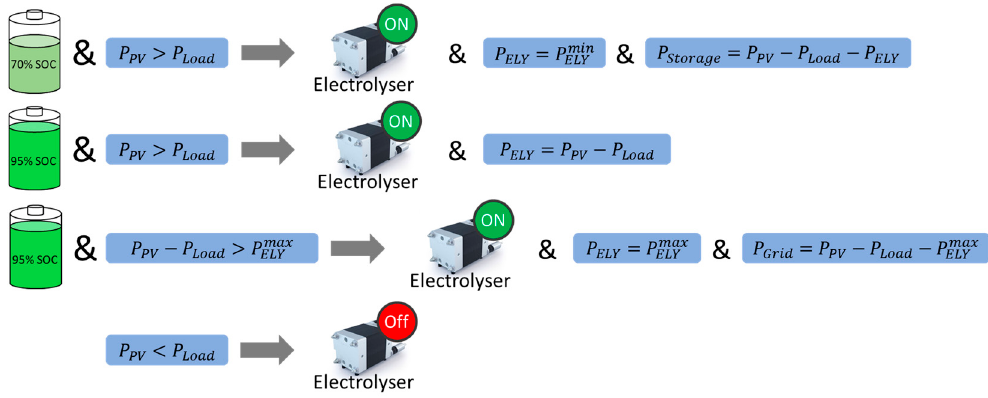
Figure 6. Control and operation scheme of the electrolyser (ELY image source: [29]).